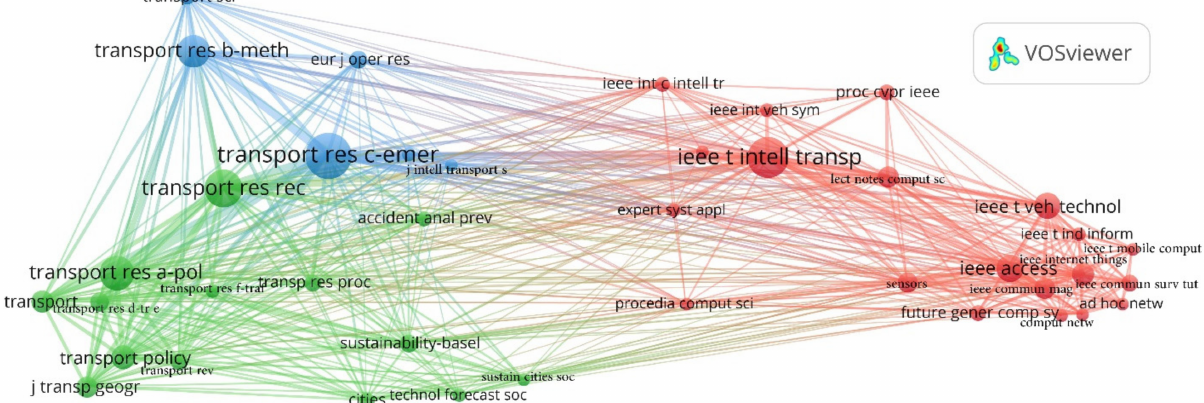
Figure 5. Most influential sources. Illustration by